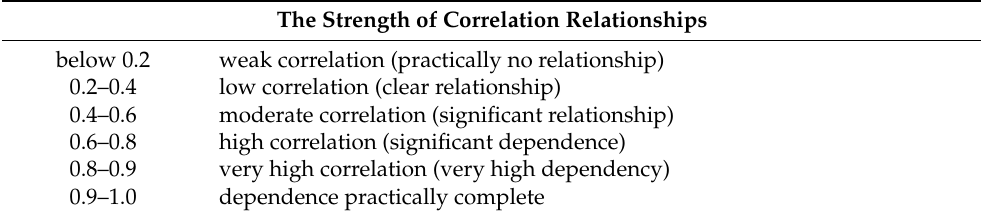
Table 2. Description for correlation relationships.